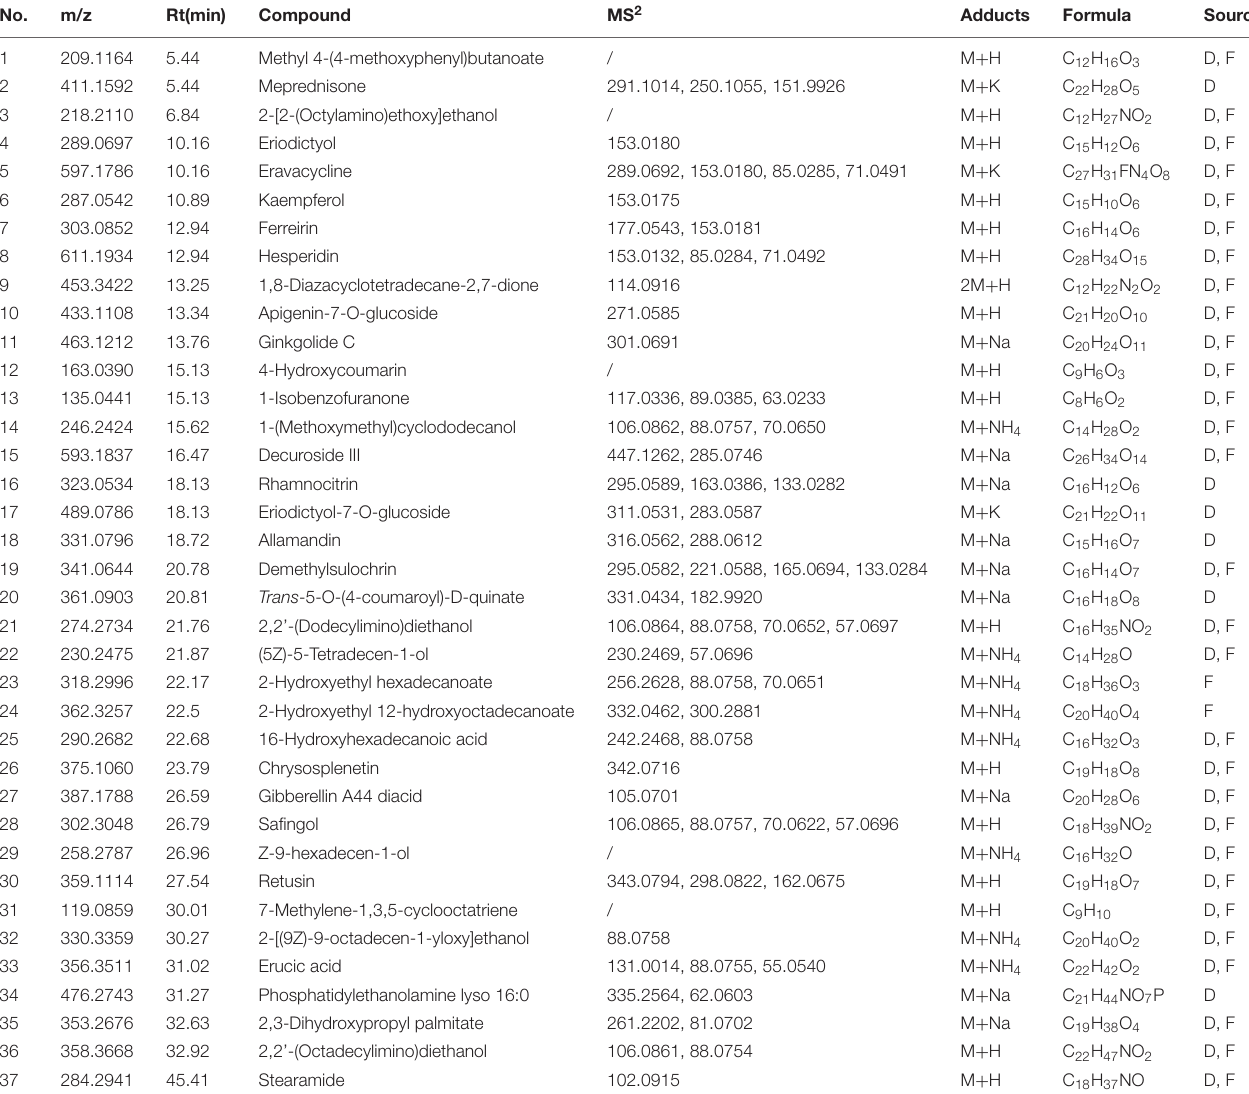
TABLE 1 | List of identified metabolites of spearmint ( Mentha spicata